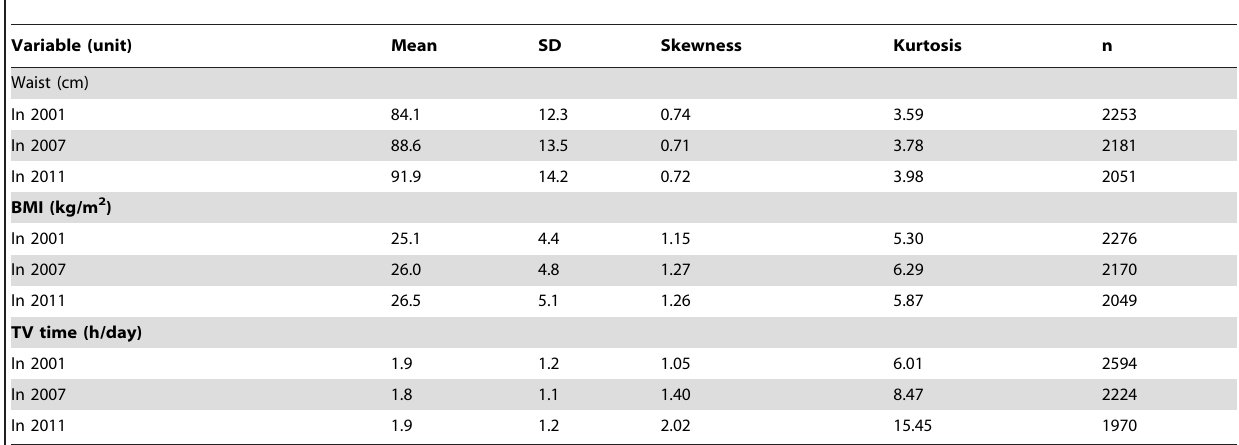
Table 1. Basic Characteristics for temporal sequence